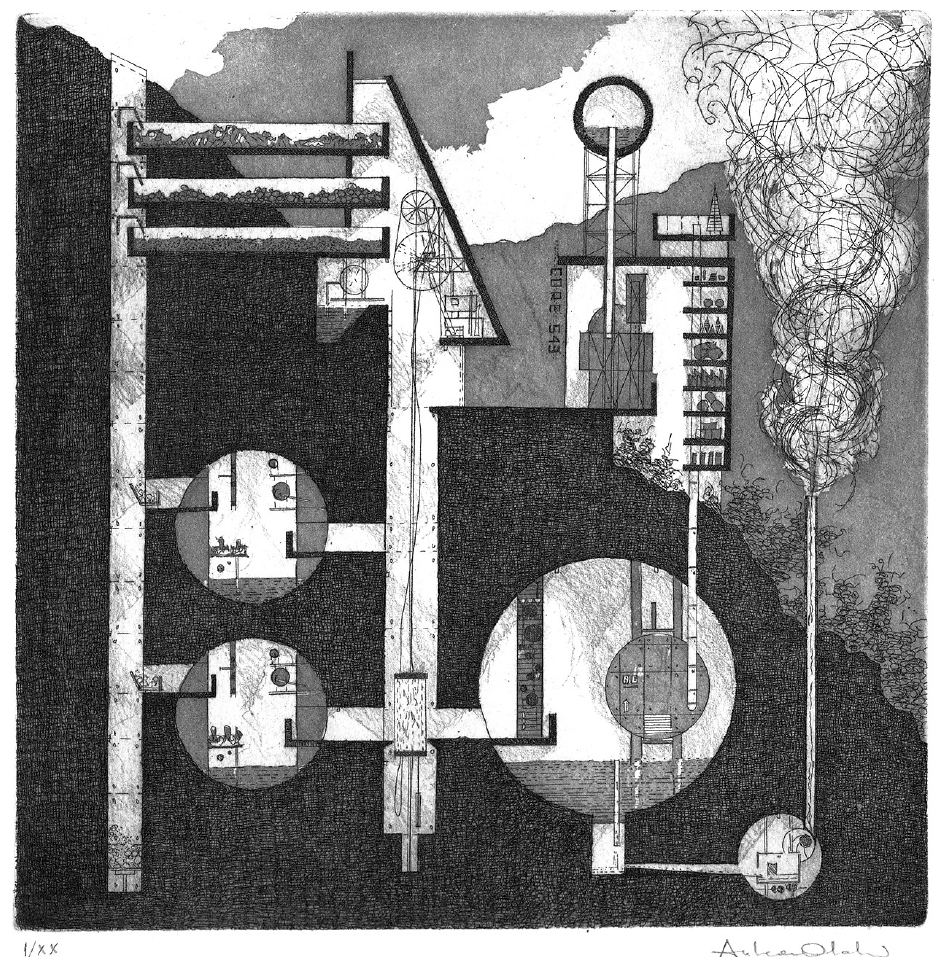
Fig. 4 Andrea Oldani, «Core 543» an hypothetical groundscape , 2017. Plate: cm. 17,5 x 17,7. Etching/Soft Ground/